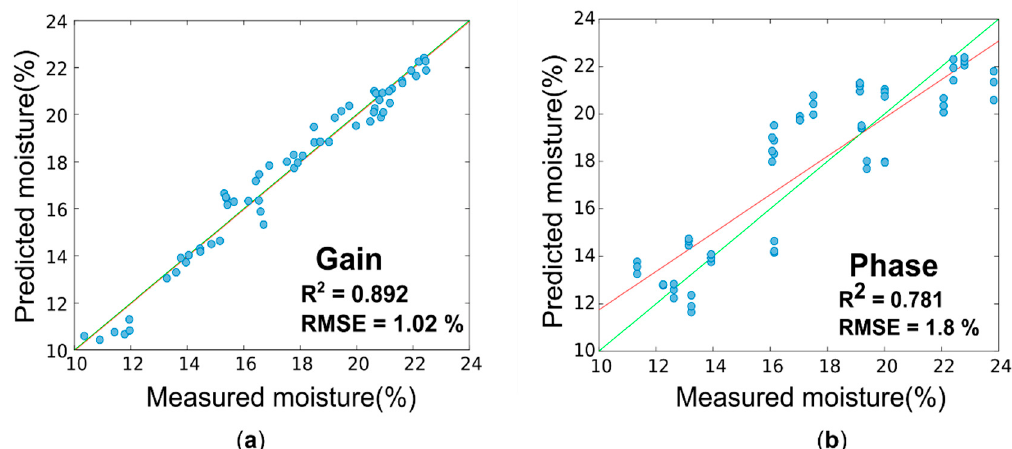
Figure 11. Predicted versus observed values of the moisture content (%) for test set validation of ( a ) gain data and ( b ) phase data. The red line is the line regression for the test samples (so not used for the model creation), whereas the green one is the bisector representing the ideal case. RMSE, root mean square error.